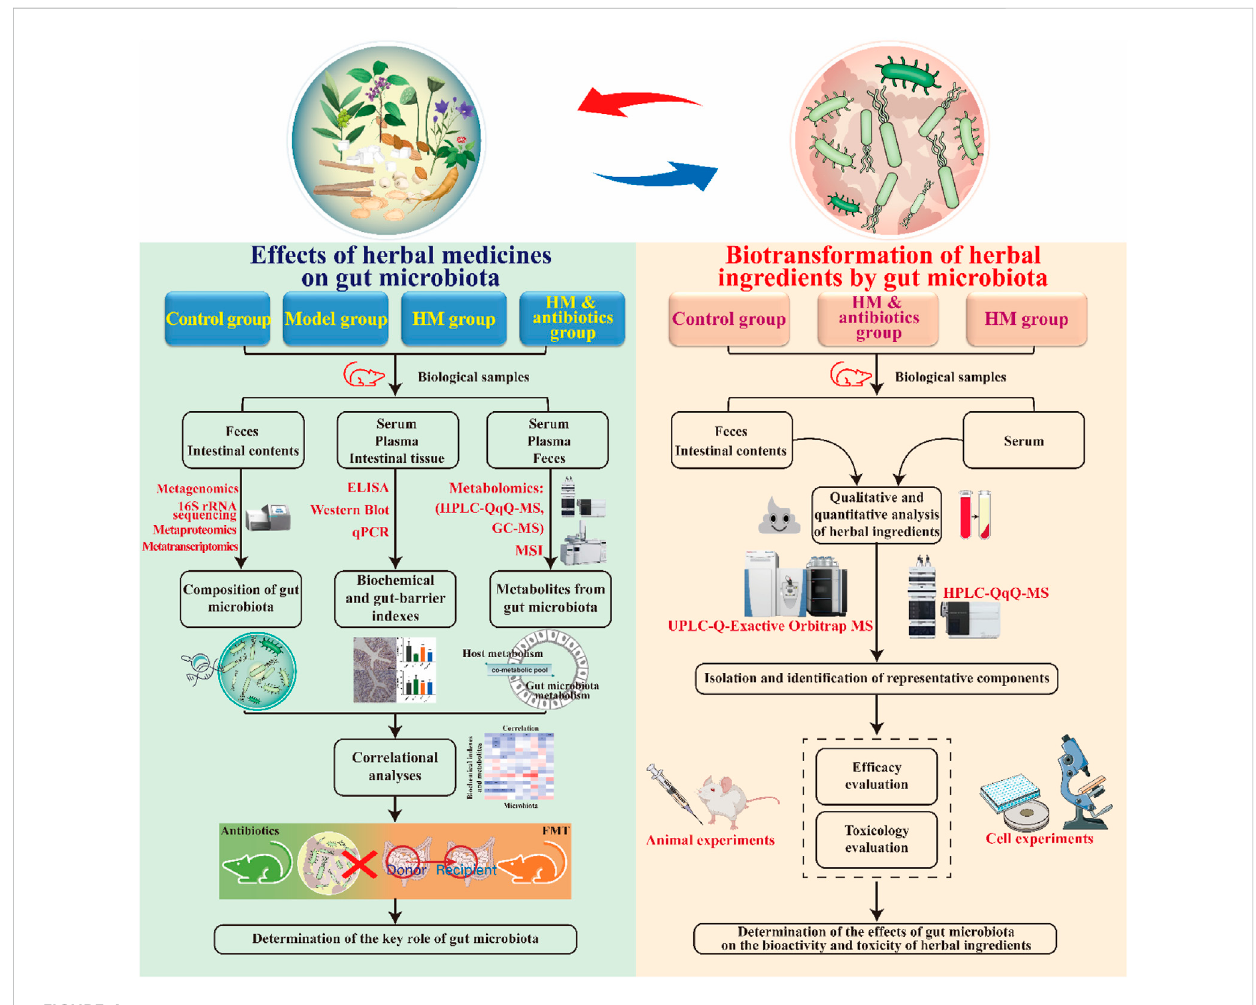
FIGURE 4 Methodology for studying the bidirectional interaction between herbal medicines and the gut microbiota. HM, herbal